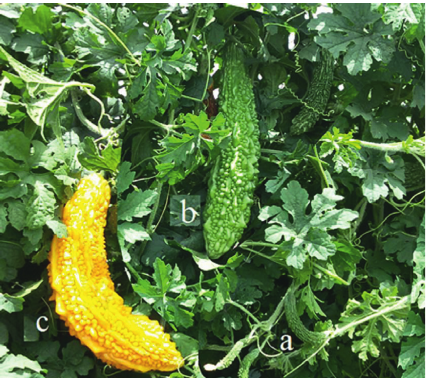
Figure 1: Different growth levels of BG: (a) immature stage, (b) mature stage, and (c) ripen